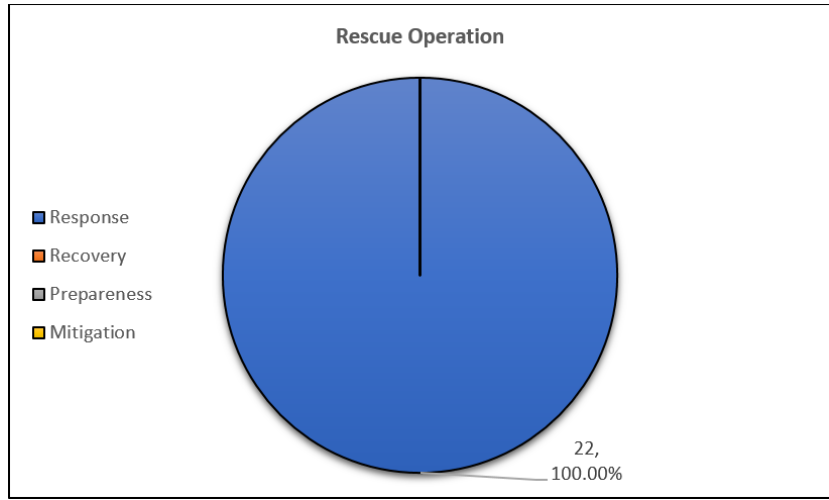
Figure 9. Breakdown of VRP for Rescue Operation based on DM